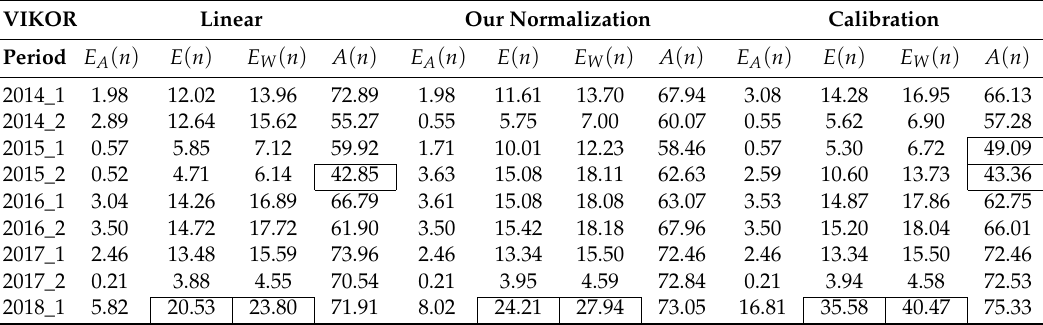
Table 8. Values of indicators obtained with VIKOR